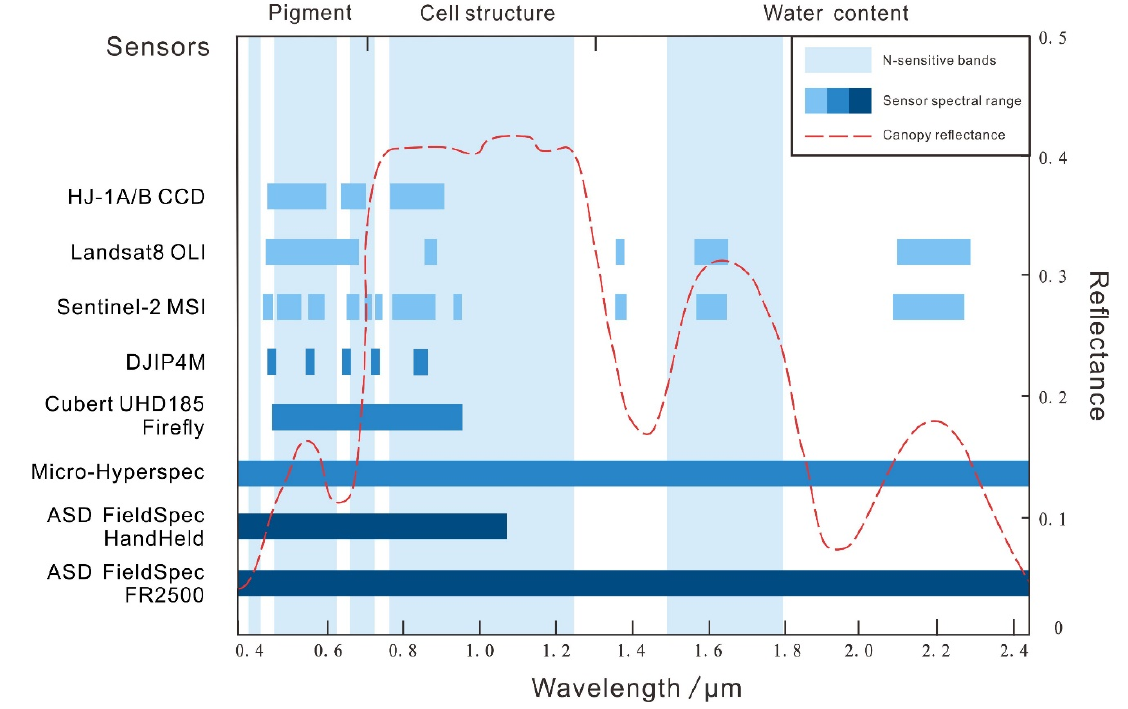
Figure 4. Spectral reflectance properties of crop canopy and spectral range of different platform sensors.